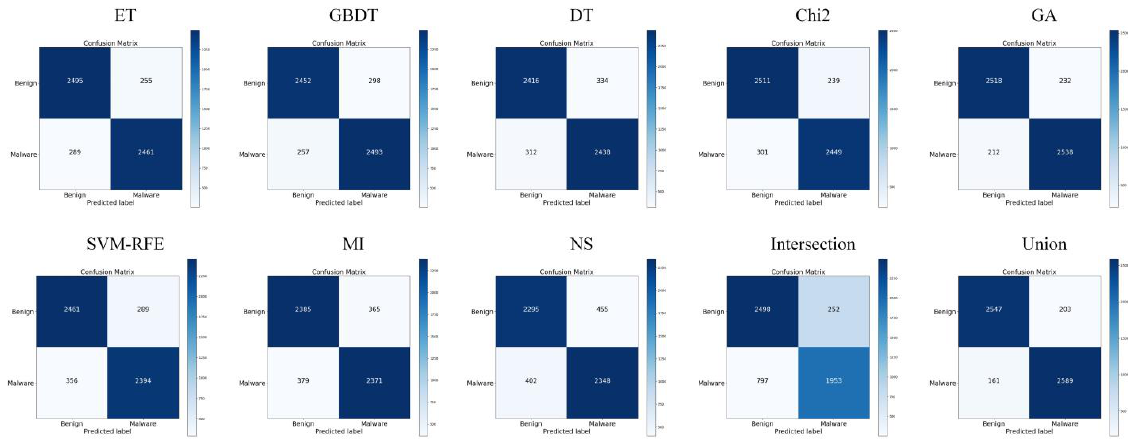
Figure 9. Confusion matrix of different feature selection methods on OmniDroid dataset.